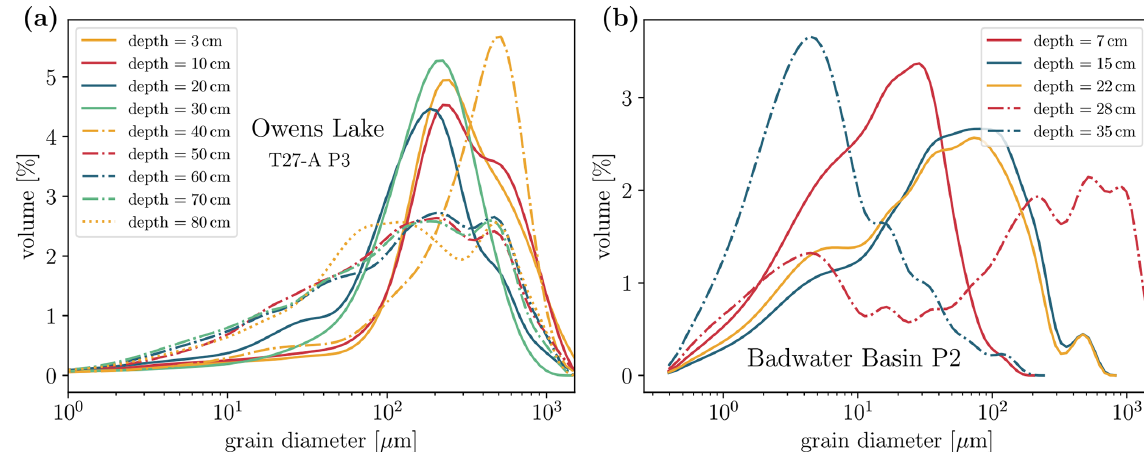
Figure 6. Exemplary grain size (diameter) profiles for (a) site T27-A P3 at Owens Lake and (b) site Badwater Basin P2.